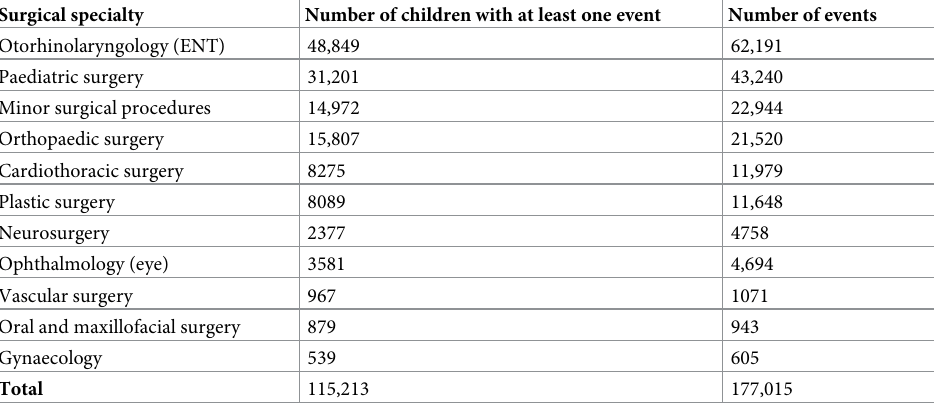
Table 2. Number of surgical procedures in public hospitals by surgical specialty, Danish children 0–5 years of age, 1999–2018. Surgical